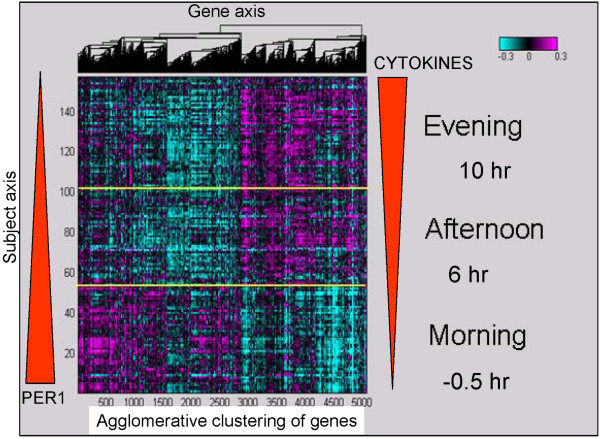
The impact of diurnal rhythm on global gene expression changes in all subjects. This heatmap illustrates that more than 5,000 genes were significantly associated with diurnal rhythm in the human adipose tissue over multiple days and subjects, irrespective of treatment arm. PER1 mRNA levels decreased and cytokine mRNA levels increased from the morning to the evening (red block arrows depict levels schematically). The y-axis lists the subjects ordered by time of biopsy and the x-axis lists diurnally regulated genes clustered hierarchically with the agglomerative clustering algorithm. The heatmap color scale is in log10, arranged from magenta (upregulated) to cyan (downregulated).